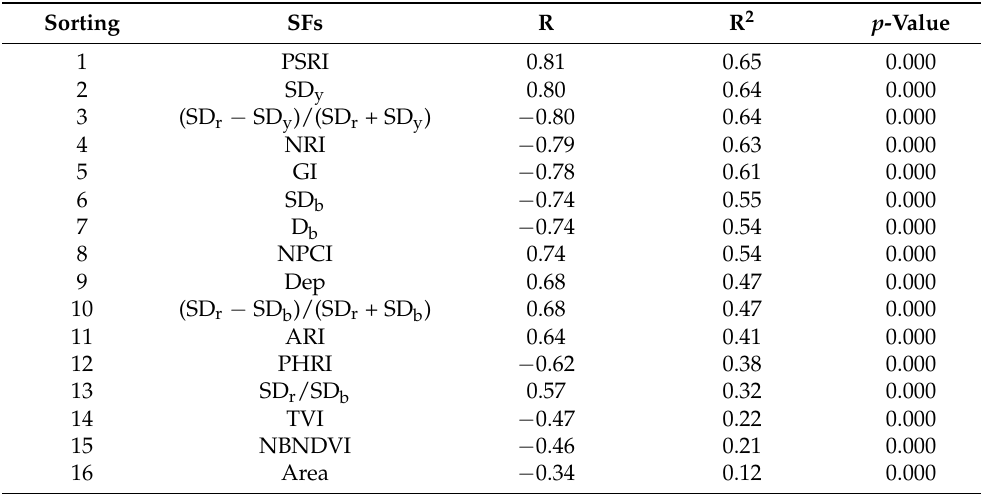
Table 3. The correlation between traditional spectral features and disease severity.